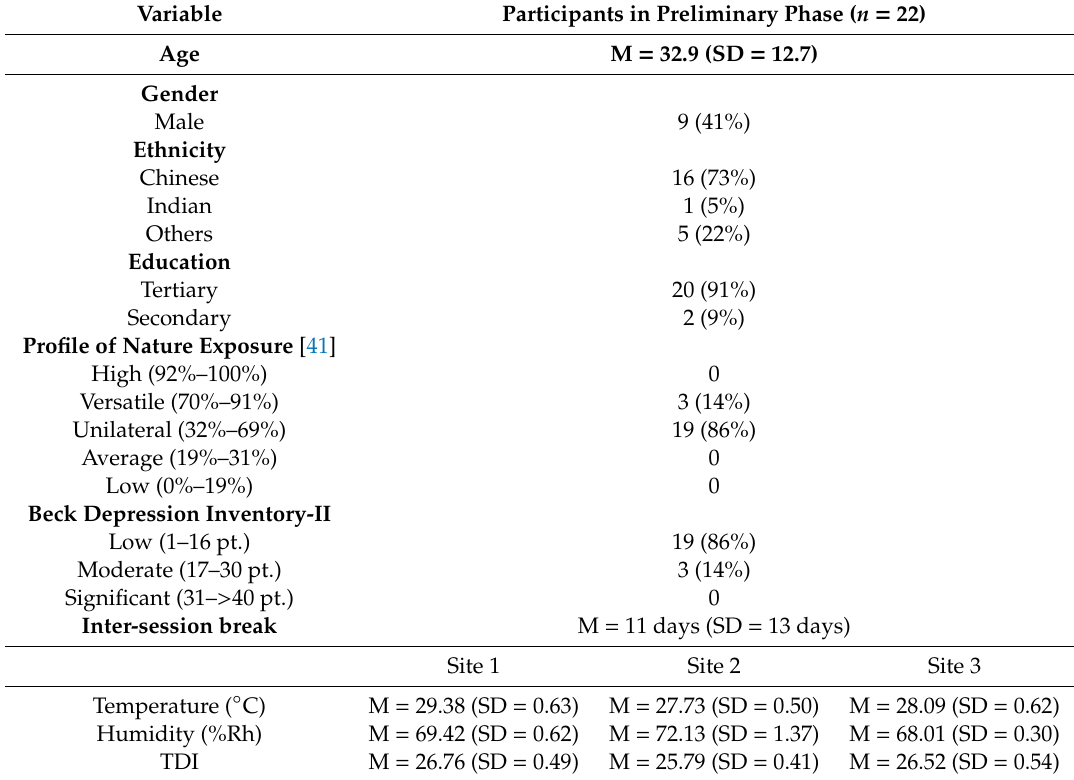
Table 1. Sample characteristics (mean, SD or